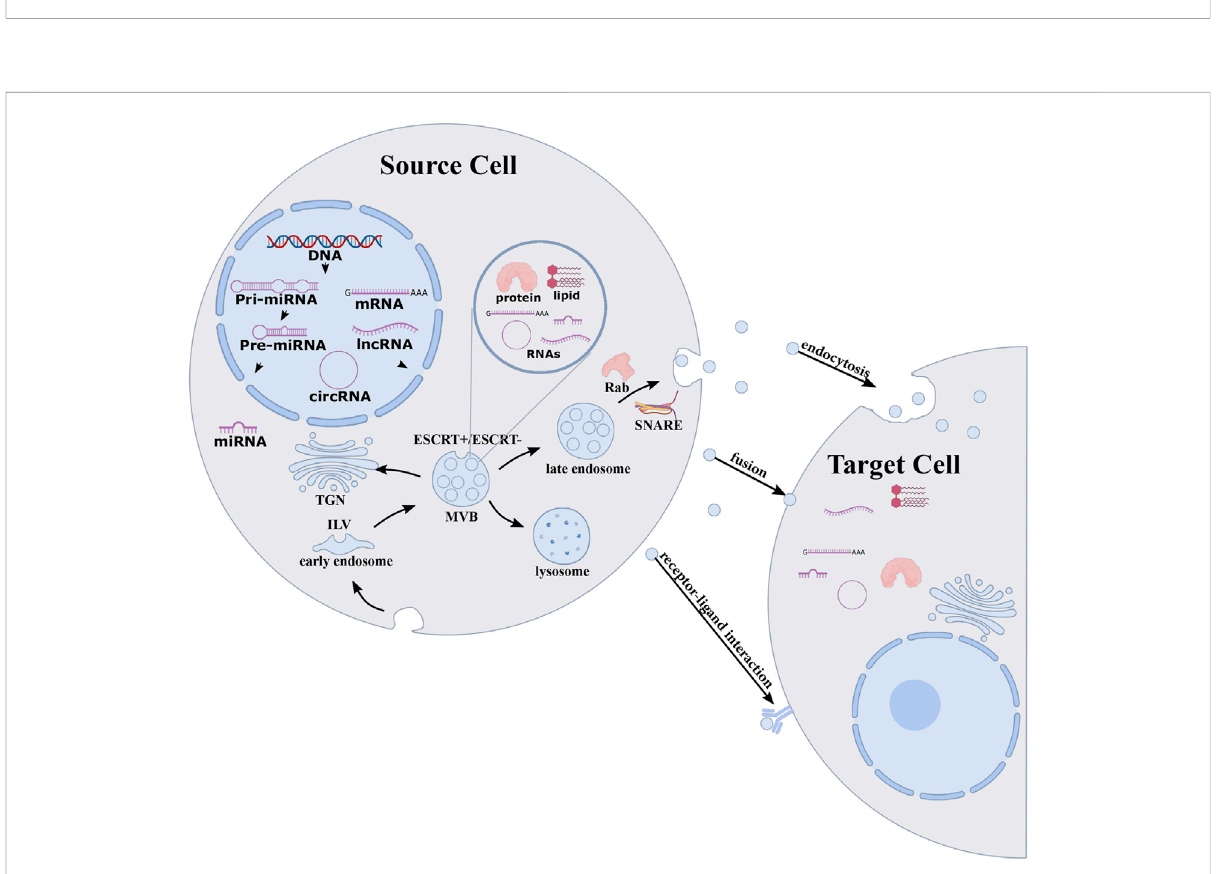
FIGURE 3 sortingmechanismforexosomalmiRNAs.MiRNAoriginatesinnucleusandenzymaticallyprocessedtoformmaturemiRNAthatareloadedinto the MVBs through endosomal sorting complex required to transport ESCRT-dependent or ESCRT-independent pathways. MVBs of endosomes migrate to the plasma membrane and fuse, causing exosome and exosomal cargoes to be released into the extracellular space and delivered to target cells. Reprinted with permission from Yue et al.